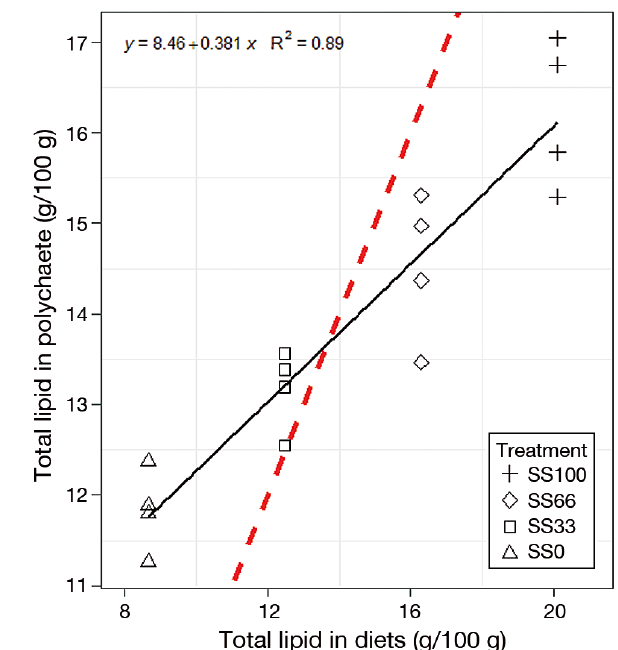
Fig. 3. Relationship between the total lipid content of Hediste diversicolor and total lipids in experimental diets. Dotted red line: equality between the total lipid in diets and in polychaetes. See Table 1 for treatment